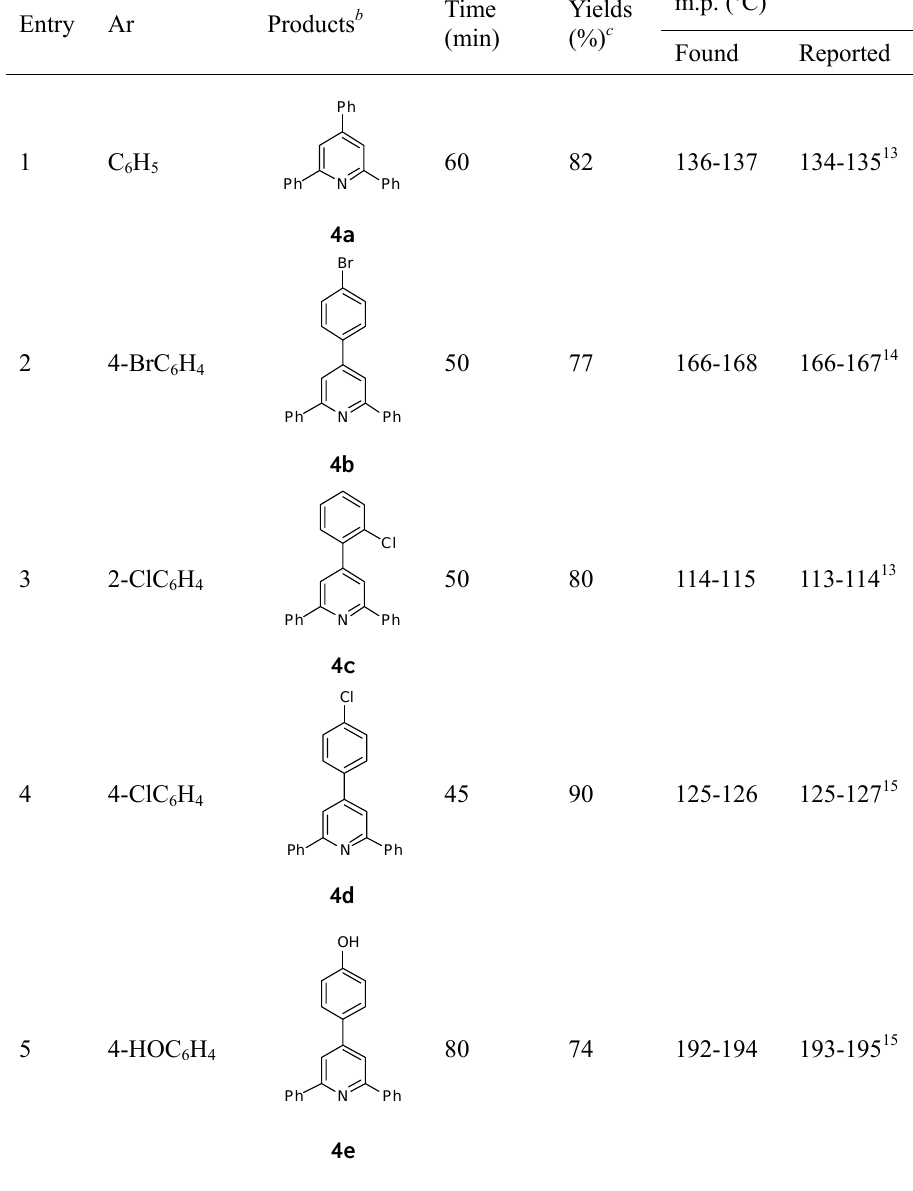
catalyzed synthesis of 2,4,6-triarylpyridines 4a-j a Table 2. PPA-SiO 2